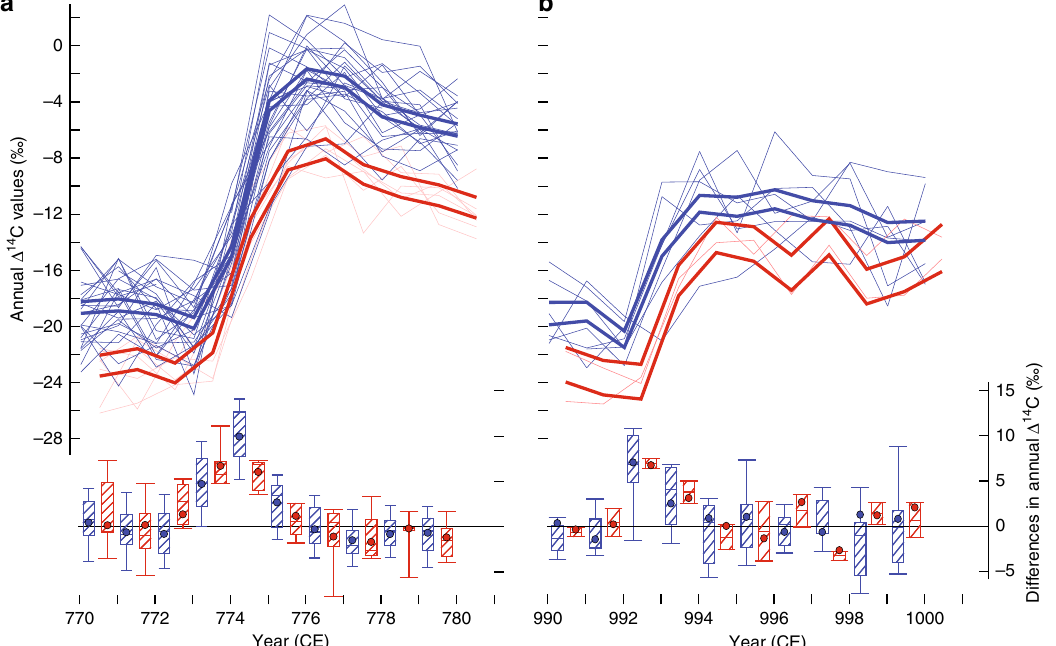
Fig. 2 COSMIC signature. a Annual 14 C content of 374 tree rings formed between 770 and 780 CE at 27 and seven sites across the NH and SH (light blue and red lines), respectively (Supplementary Fig. 2). b 14 C content of 110 tree rings from 990 – 1000 CE at eight and two sites in the NH and SH (blue and red lines), respectively. Thick lines bracket standard uncertainties around hemispheric means, lower box plots reveal year-to-year 14 C differences (median, 25th and 75th percentiles), and SH data have been shifted relative to the earlier NH